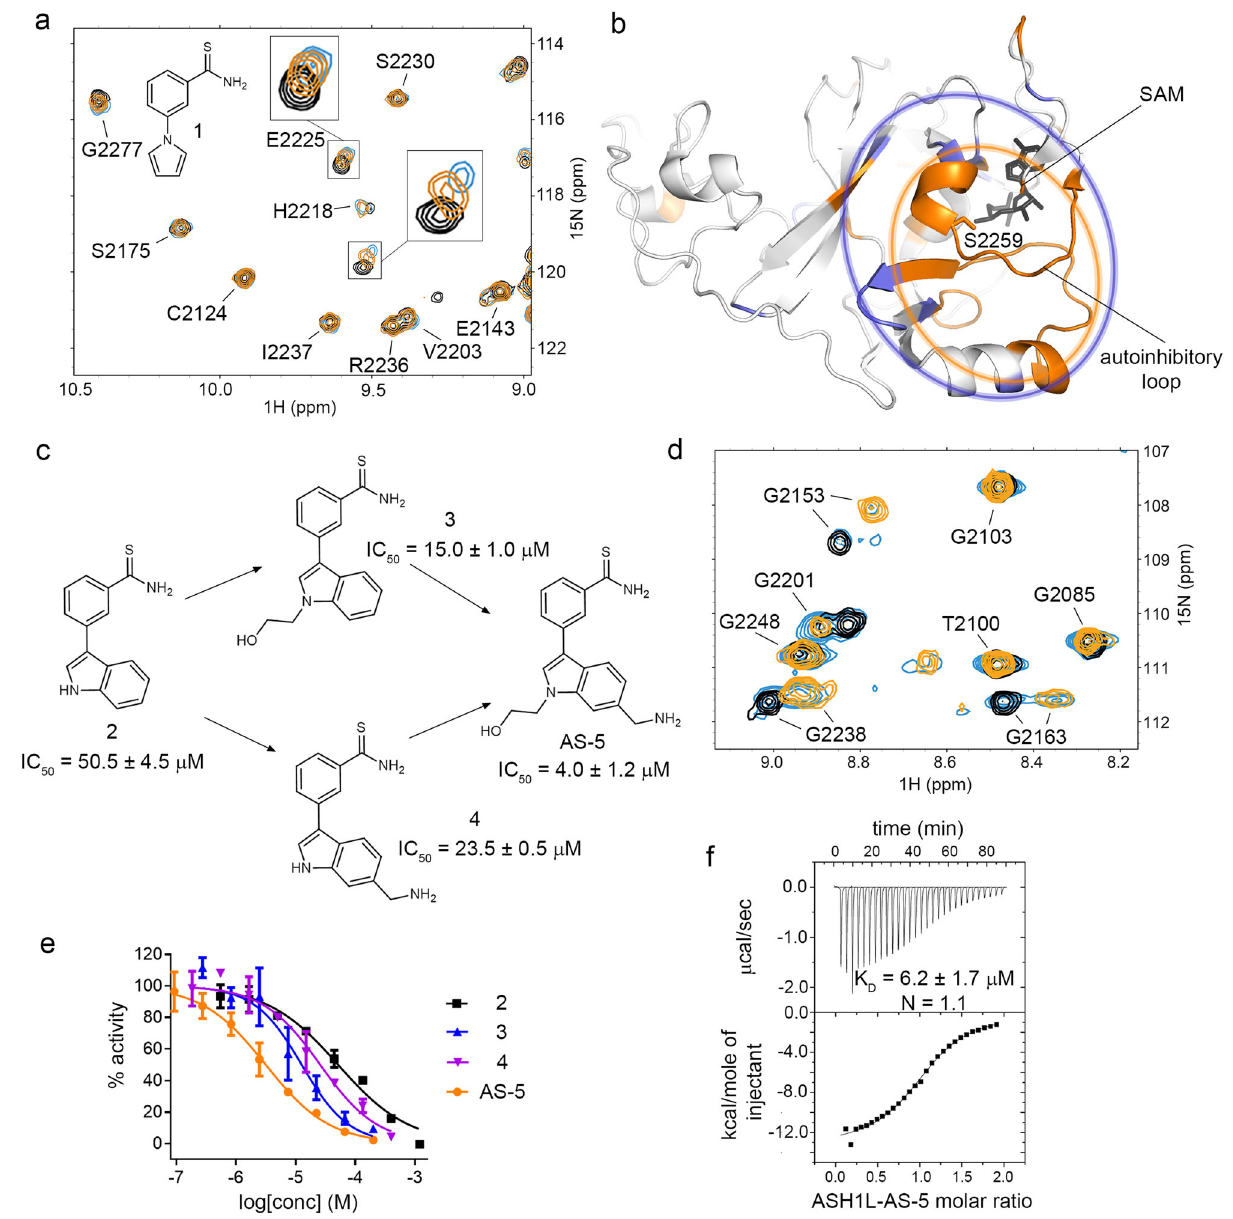
Fig. 2 Development and characterization of ASH1L inhibitors. a Structure of the fragment hit, compound 1 , and its binding to ASH1L SET domain. Superposition of the 1 H- 15 N TROSY-HSQC spectra of 100 µ M ASH1L with 5% DMSO (black) with 500 µ M (orange) or 1mM (blue) of compound 1 . b Chemical ffiffiffiffiffiffiffiffiffiffiffiffiffiffiffiffiffiffiffiffiffiffi q shift perturbations upon binding of 1 to ASH1L mapped on the crystal structure of ASH1L SET domain (PDB code 4YNM). Residues experiencing chemical shift ð δ 2 þ δ 2 Þ perturbations calculated as 4 HN ¼ larger than 15Hz are colored and encircled in violet. Residues unobserved or unassigned are colored and HN N encircled in orange. c Chemical structures and activities for selected ASH1L inhibitors. IC 50 values represent mean±s.d. from two independent experiments. d Superposition of the 1 H- 15 N TROSY-HSQC spectra of 100 µ M ASH1L with 5% DMSO (black) and with 500 µ M (orange) or 100 µ M (blue) of AS-5 . e Titration curves from the HMT assay for ASH1L with compounds presented in panel ( c ) mean±s.d. Representative curves are shown from two independent experiments, each performed in duplicates. f Binding isotherm from the ITC experiment performed for the binding of AS-5 to ASH1L. Data are mean±s.d. from two independent experiments. A representative binding isotherm is shown. N represents stoichiometry of